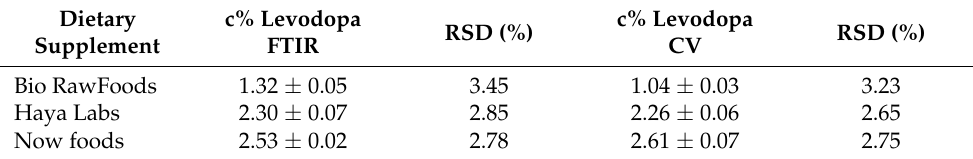
Table 7. L-DOPA concentrations obtained from the two analysis methods used in this study. Dietary